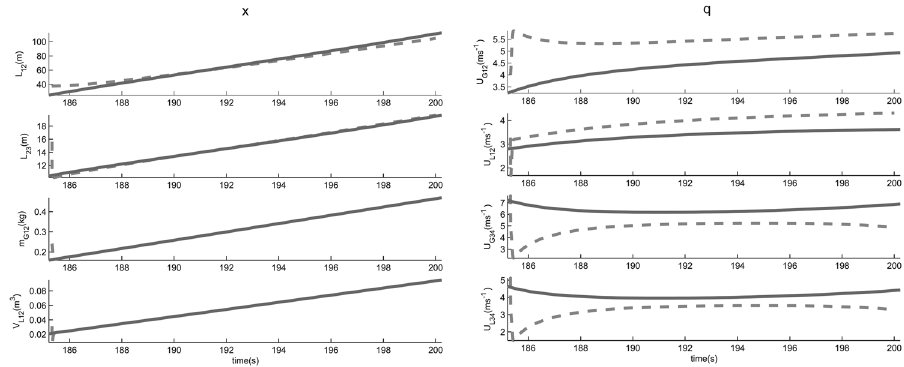
Figure 6. Simulation trial of observer with model uncertainty: x and q (solid) compared with x est and q est